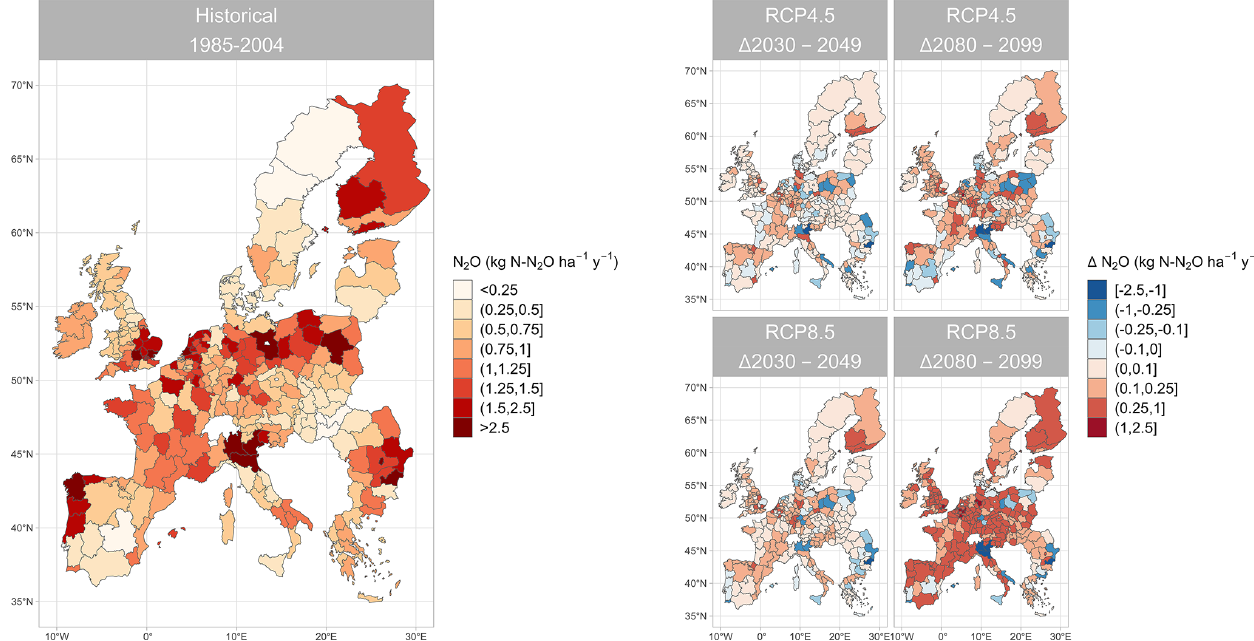
Figure 5. N 2 O emissions for croplands and grasslands in European administrative regions (NUTS2). Emissions are reported for the historical period (1985–2004) and difference (cid:49) from the middle (2030–2049) and the end (2080–2099) of the century for the two climatic scenarios RCP4.5 and RCP8.5. N 2 O emissions are reported for cropland with the irrigable scenario (see the text).